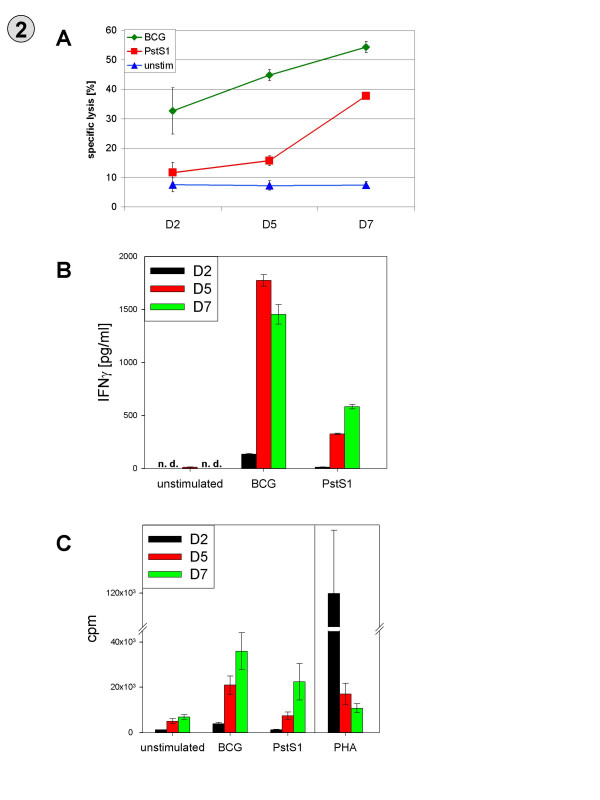
Time-course of PBMC stimulation. PBMC were stimulated with PstS1 (10μg/ml), BCG (4 × 104 CFU/ml), PHA (2,5 μg/ml) or left unstimulated. Cytotoxicity (A), IFN-γ-production (B) and proliferation (C) of PBMC were measured after 2, 5 and 7 days of stimulation. A Cytotoxicity assay. 4-hour chromium release assay against T-24 bladder tumor cells. Effector-target cell ratio of 40:1. B IFN-γ release measured by ELISA from culture media of PBMC. C PBMC proliferation measured by overnight 3H-Thymidine incorporation assay (1 μCi/2 × 105 cells). For A and B one representative experiment out of 3 is shown (mean ± SD), for C a composite of seven independent experiments is shown (mean ± SEM). For PHA-stimulation one out of two experiments is shown (mean ± SD) . n.d. = not detectable